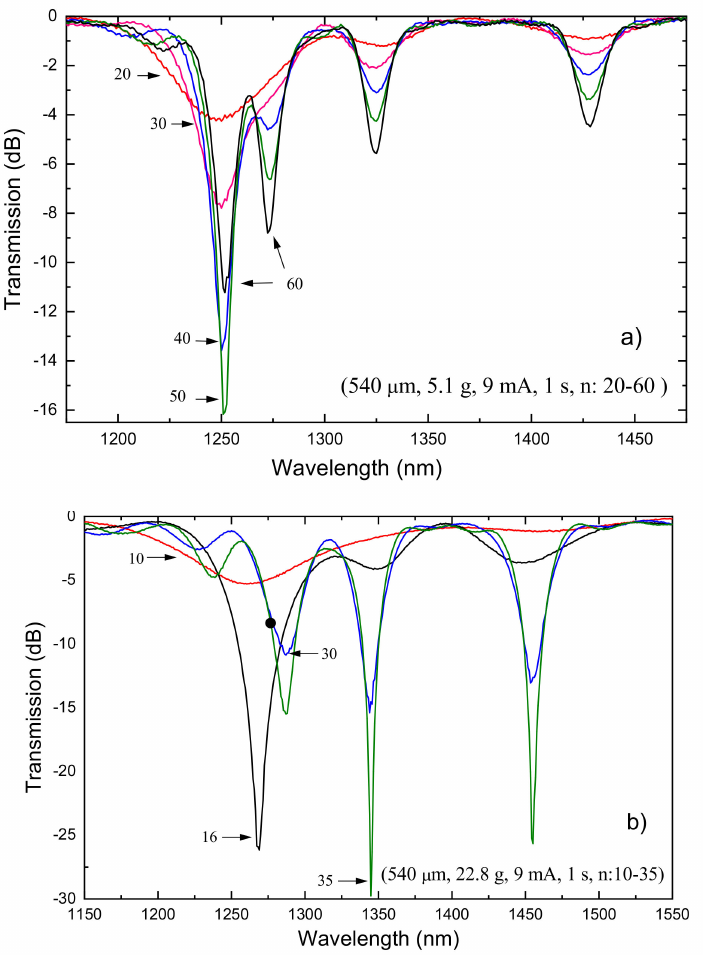
Figure 5. Influence of the fabrication parameters. Evolution of two LPFGs inscribed in the Sumitomo